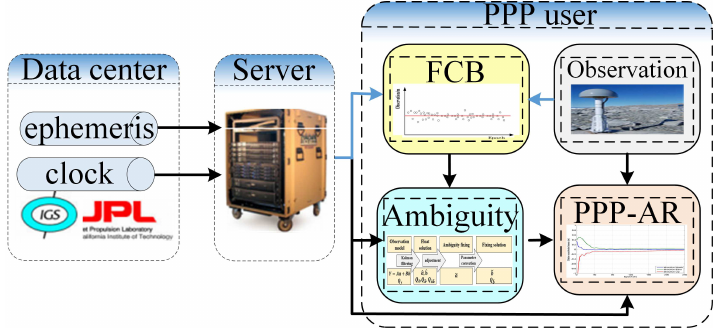
Figure 2. PPP positioning system without the assistance of the real-time network